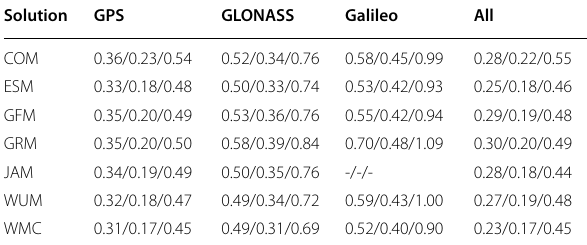
Table 3 RMS of the east/north/up components for daily PPP using the precise orbit and clock of each analysis center as well as the combined solutions for different constellations. ‘WMC’ indicates the combined solutions in this study (unit: cm) Solution